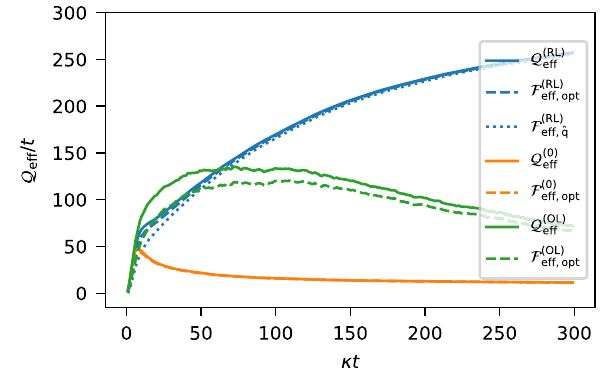
FIG. 11. Q eff / t (solid lines) and F eff / t for homodyne detection (dashed lines) as a function of κ t for the three different strategies under consideration. Use of homodyne detection as a final strong measurement does not affect the precision in the estimation sig- nificantly for the RL strategy, given that the biggest contribution to Q eff comes from the continuous monitoring. The dotted blue line shows F eff / t for homodyne detection on the ˆ q quadrature for the RL strategy. Even without optimizing the angle of the final homodyne measurement, the RL strategy allows one to exceed the performances of the benchmark strategies (parameter values are fixed as in Fig.